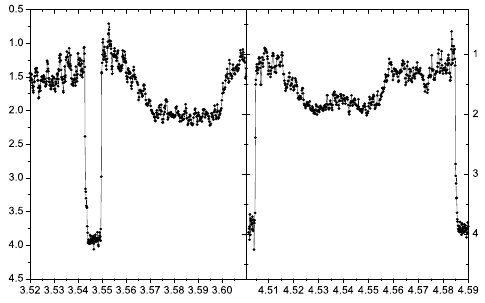
Figure 4: Two light curves of HU Aqr observed at low brightness states with the 2.15-m Jorge Sahade tele- scope in Argentina. It is shown that the brightness around phases 0.5 shows a large dip. The light curve in the left was obtained on Nov. 11, 2011, while that in the right was obtained on Nov. 12. At the bottom of the eclipse, all of the hot spot, the white dwarf, and the accretion stream are eclipsed by